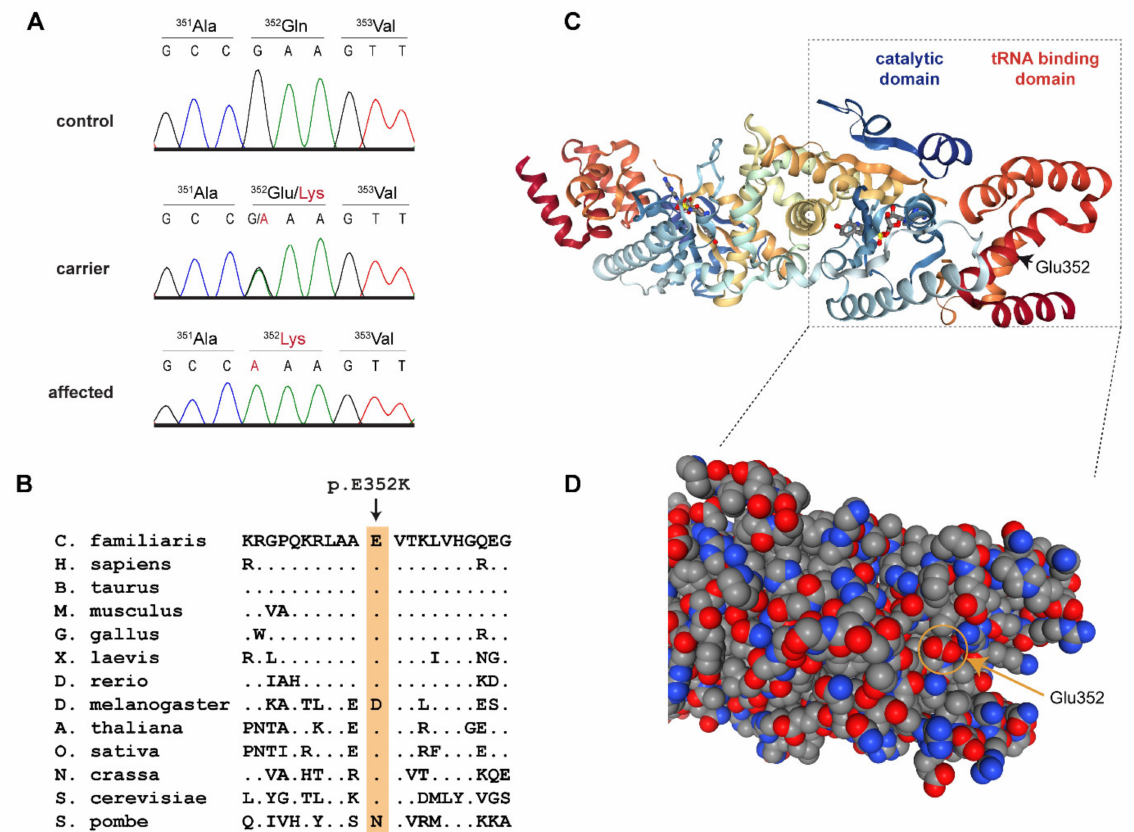
Figure 3. Details of the YARS2 :p.Glu352Lys variant. ( A ) Representative Sanger electropherograms of a control, a carrier, and an a ff ected dog illustrate the c.1054G > A variant. The amino acid translations are shown. ( B ) Evolutionary conservation. The glutamate at position 352 is highly conserved across all eukaryotes. ( C ) Three-dimensional structure of the human YARS2 protein in complex with an adenylate homolog [16–18]. The position of Glu352 is indicated in the right monomer. ( D ) Enlarged details of the structure in a space-filling model. The negatively charged carboxyl group of Glu352 is located at the surface of the tRNA binding